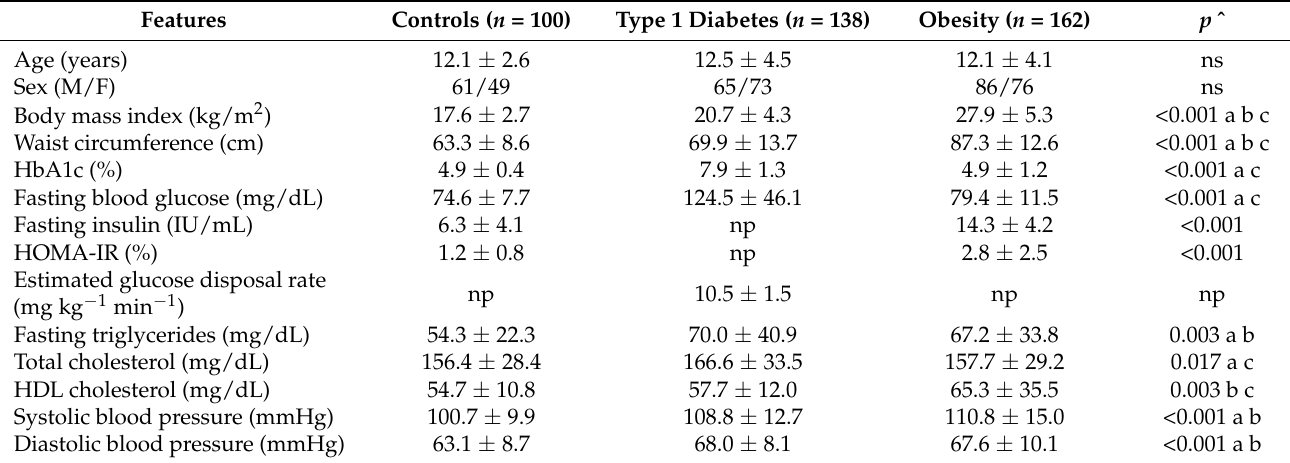
Table 1. Clinical and biochemical features of the patients and controls.